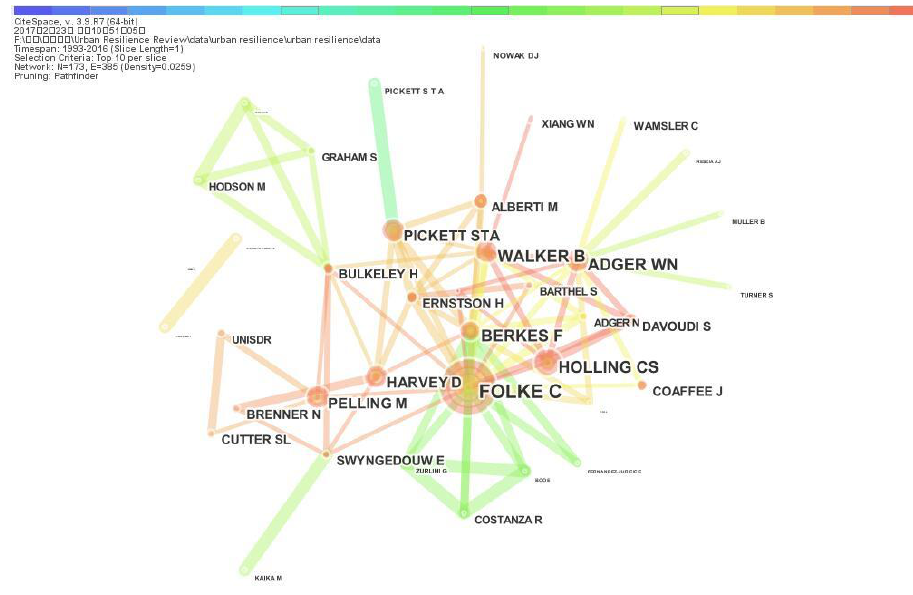
Figure 8. Author co-citation network.